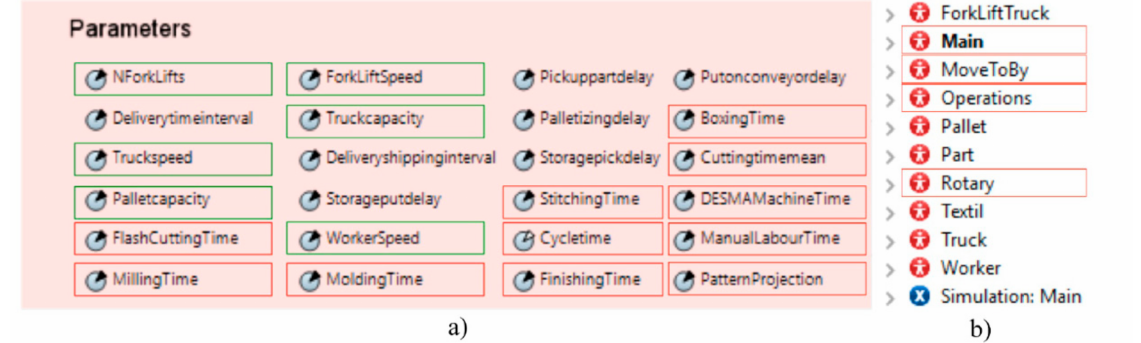
Figure 4. ( a ) System parameters (with a green frame the parameters that represent agent characteristics are outlined while parameters framed in red represent the main times of the system). This representation is associated with the direct-injection process. ( b ) Agents denned (agents framed in red are necessary in order to store logical blocks). These agents are associated with the direct-injection